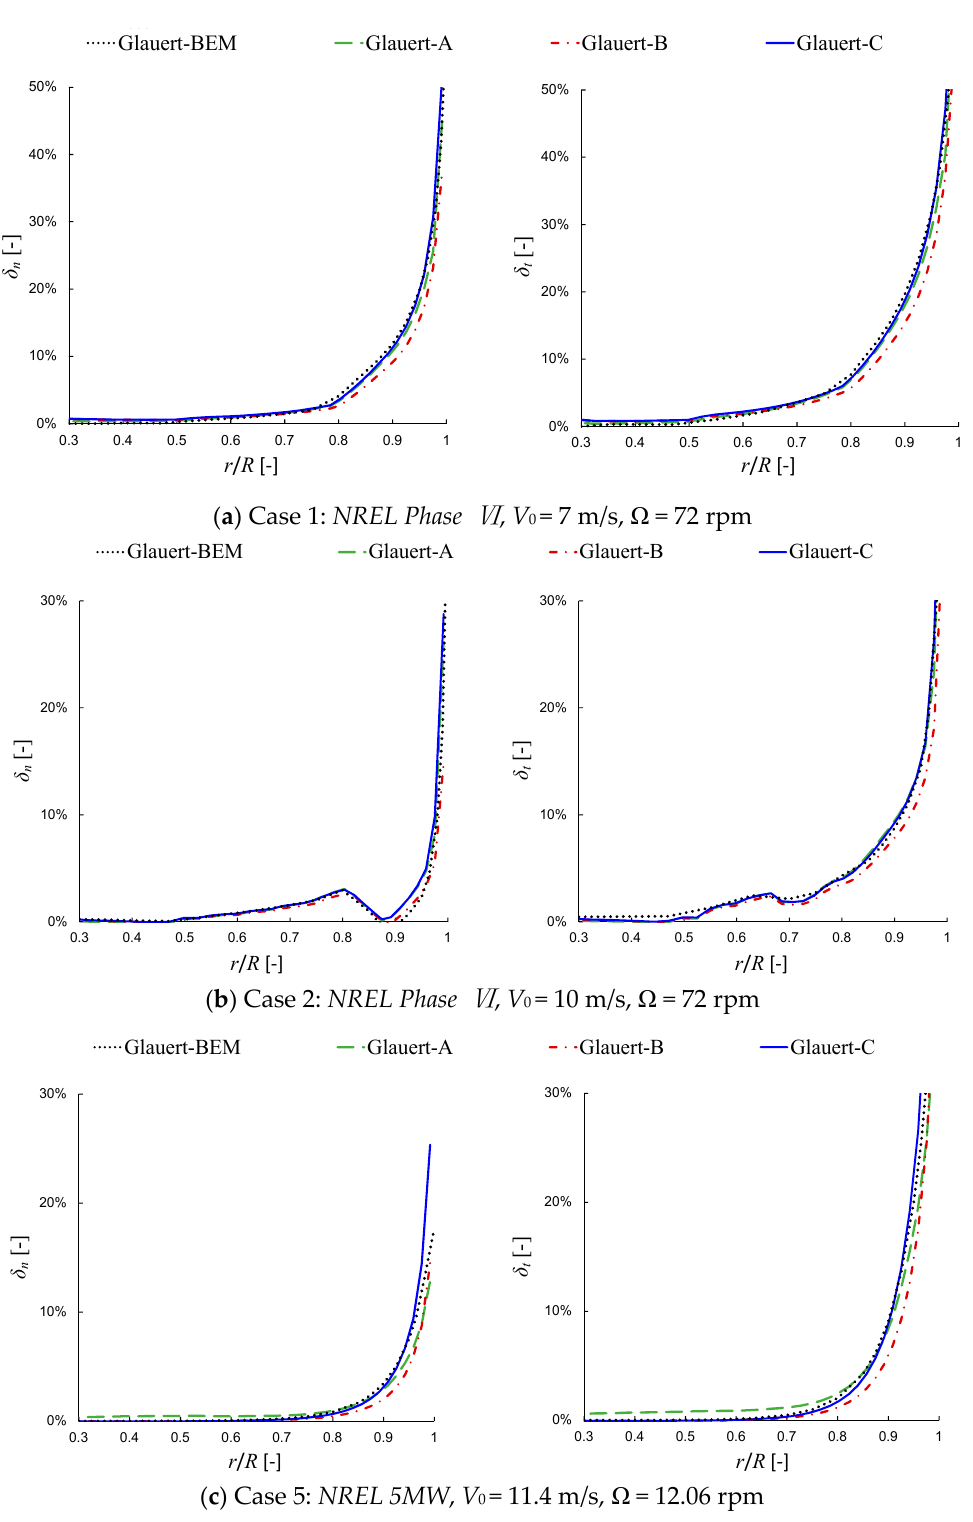
δ δ and t along a rotor blade. Figure 7. Distributions of δ n and δ t along a rotor